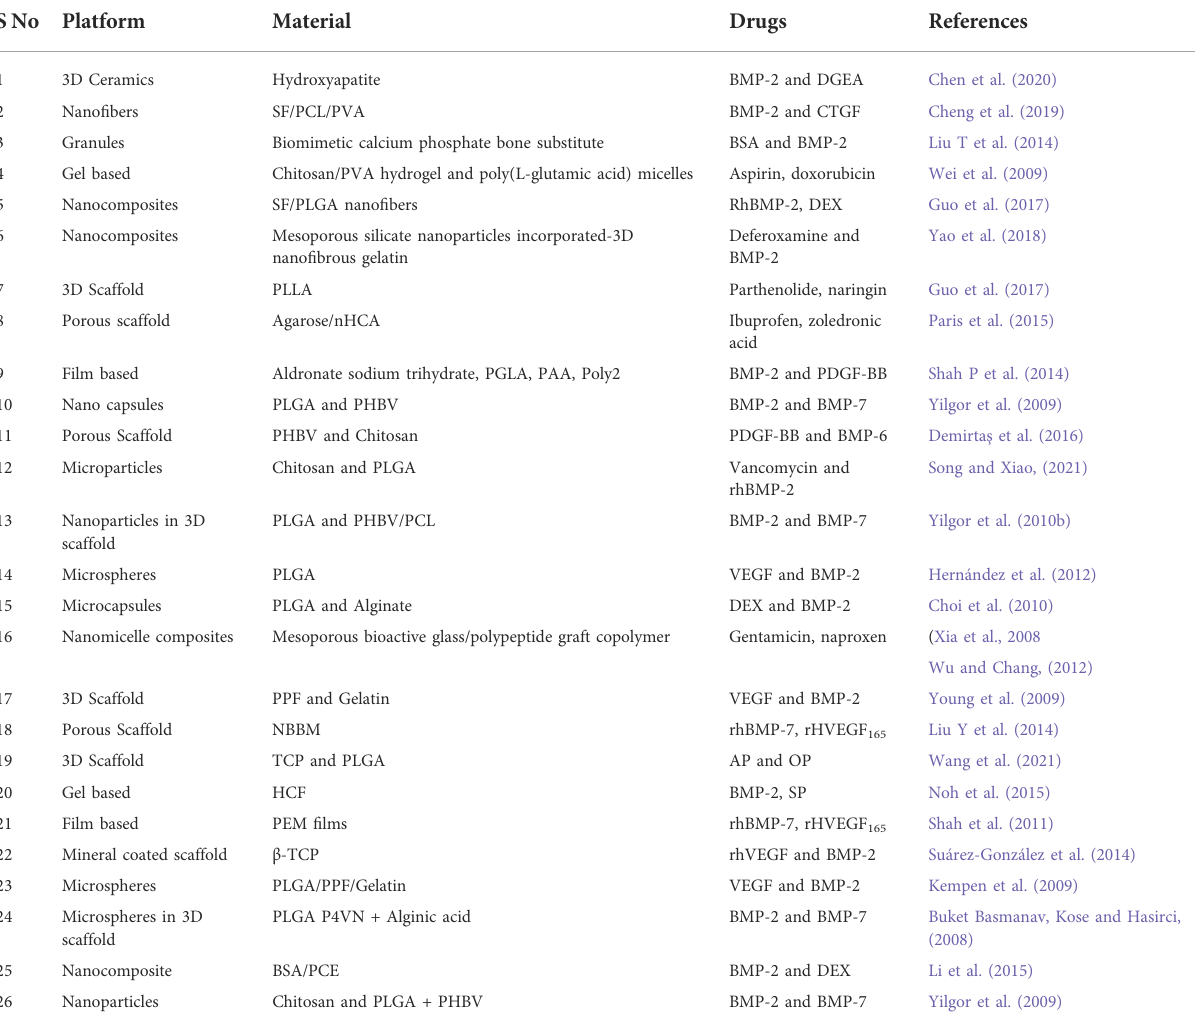
TABLE 2 Summary of various biomaterial based platforms used for dual drug